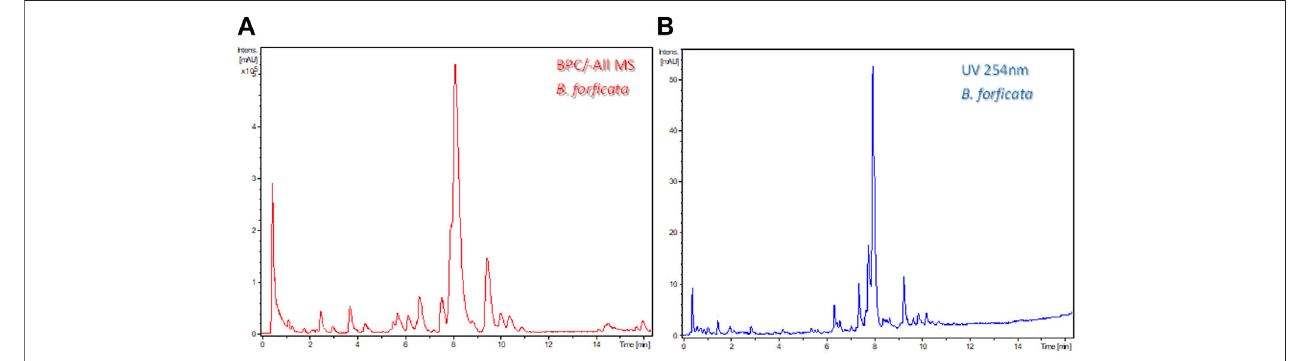
FIGURE 4 | Survey view (SV) and base peak chromatograms (BPC) in negative ionization mode (-All/MS) for B. for fi cata (1a and 1b), B. variegata (2a and 2b), B. af fi nis (3a and 3b), and B. longifolia (4a and